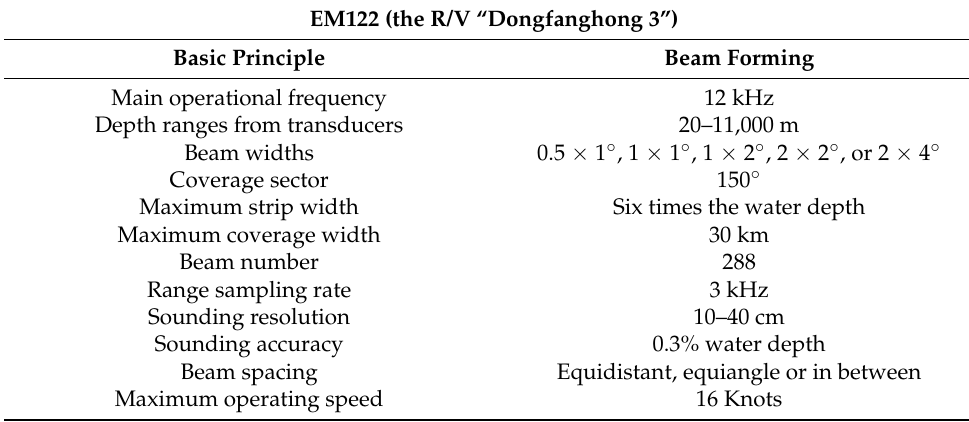
Table 1. Main parameters of the multi-beam bathymetry system